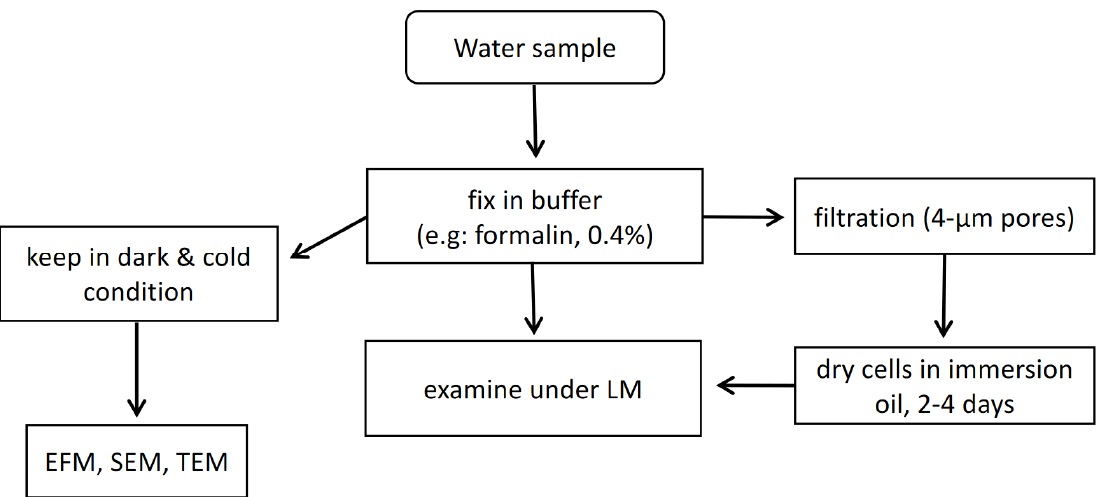
Figure 2. Simplified diagram of microscopy methods in HAB examination.